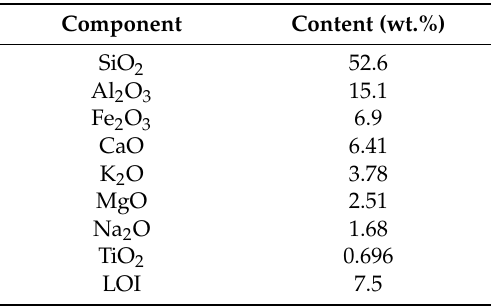
Table 1. Chemical composition of the raw clay.